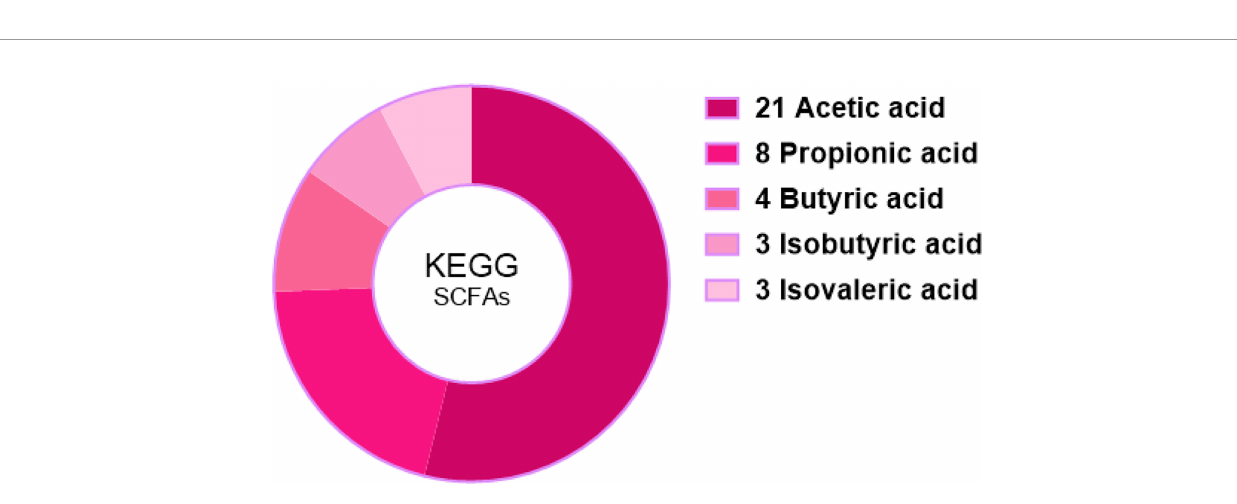
FIGURE 10 | Statistic analysis of SCFA-relevant KEGG signal pathways in the intestinal metabolism through kanehisa